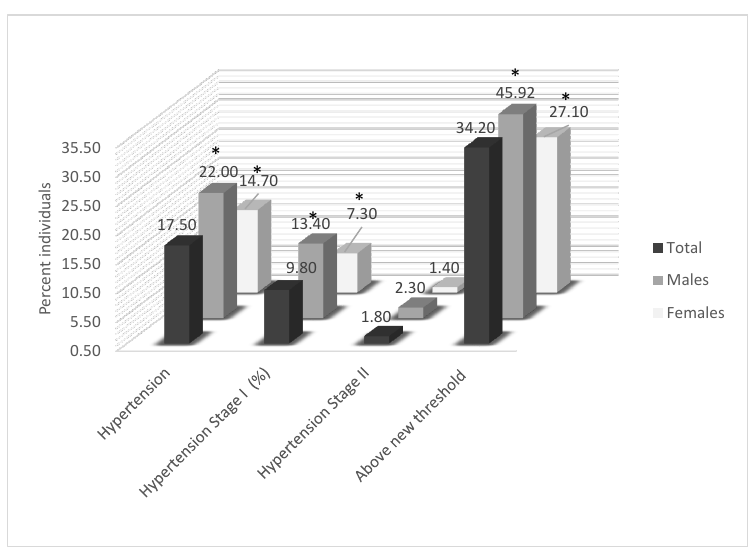
Figure 1. Blood Pressure Percentile Charts for males and females.